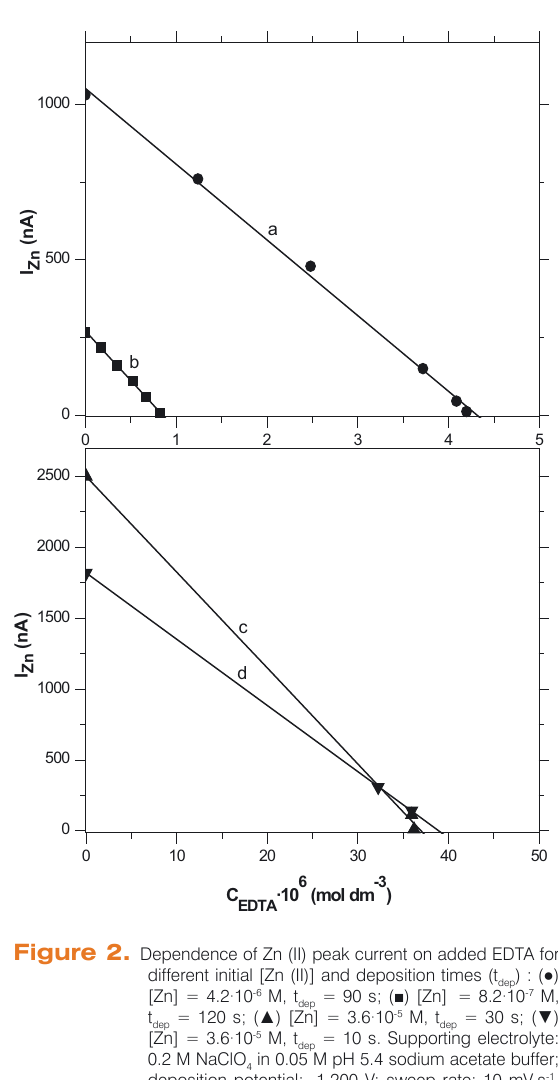
Figure 2. Dependence of Zn (II) peak current on added EDTA for different initial [Zn (II)] and deposition times (t ) : ( ● ) dep [Zn] = 4.2·10 -6 M, t = 90 s; ( ■ ) [Zn] = 8.2·10 -7 M, dep t = 120 s; ( ▲ ) [Zn] = 3.6·10 -5 M, t = 30 s; ( ▼ ) dep dep [Zn] = 3.6·10 -5 M, t = 10 s. Supporting dep